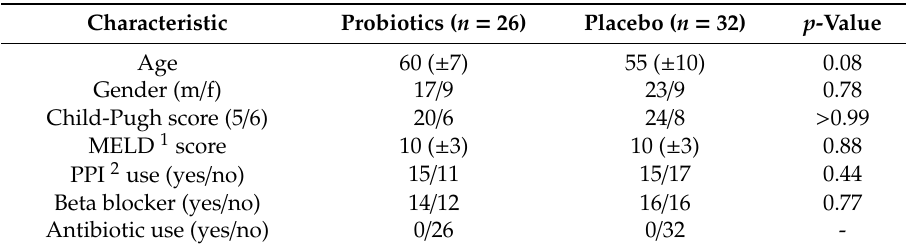
Table 1 . Baseline characteristics of patients according to allocation; data is presented as mean ( ± standard deviation) or count.